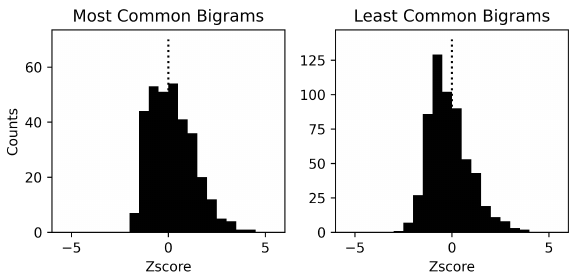
Figure 8. Histogram of Z-scores of non-adjacent bigram counts. The count of each bigram within a letter sequence was compared against the counts of other bigrams using a Z-score (mean sub- traction followed by a division by the standard deviation). We analyzed letter sequences that were longer than 100 letters. The bigrams composed of adjacent letters or the bigrams that are parts of a solution word were not included in the analysis.